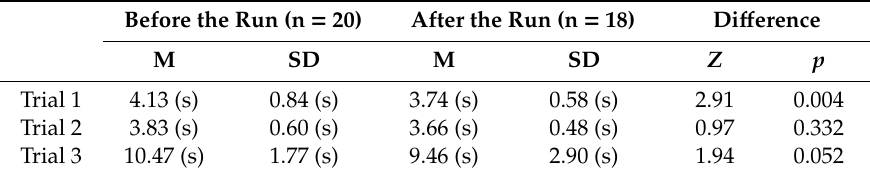
Table 2. Stroop color and word test results before and after the run. Before the Run (n =